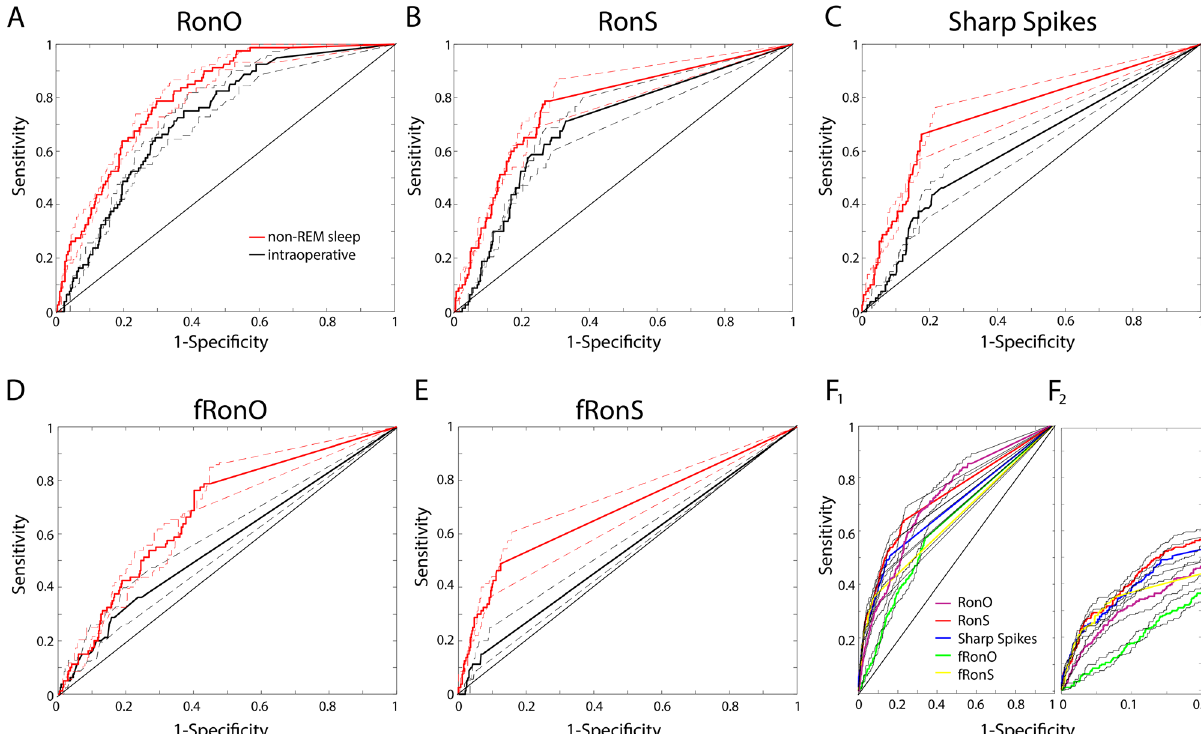
Figure 3. Comparison of receiver-operating characteristic (ROC) curves for different HFO subtype and sharp spike rates ( A – E ) in classifying the SOZ during intraoperative recordings (n = 530 contacts, black) and the same matched electrode contacts during non-REM sleep recordings (n = 530, red). Dashed lines indicate 95% confidence intervals (CI) for the ROC curves. Only sharp-spikes and fRonS had a significantly larger area under the ROC curve (AUROC) in the sleep recordings ( p < 0.05). ( F ) ROC curves for the HFO subtype and sharp spike rates using all contacts (n = 2630), including those unmatched, for classifying the SOZ sites during the non-REM sleep recordings ( F1 ). At high specificities ( F2 ), the partial AUROC of RonO and fRonO were inferior to sharp-spikes and HFOs on spikes ( p < 0.5). Black lines indicate 95%